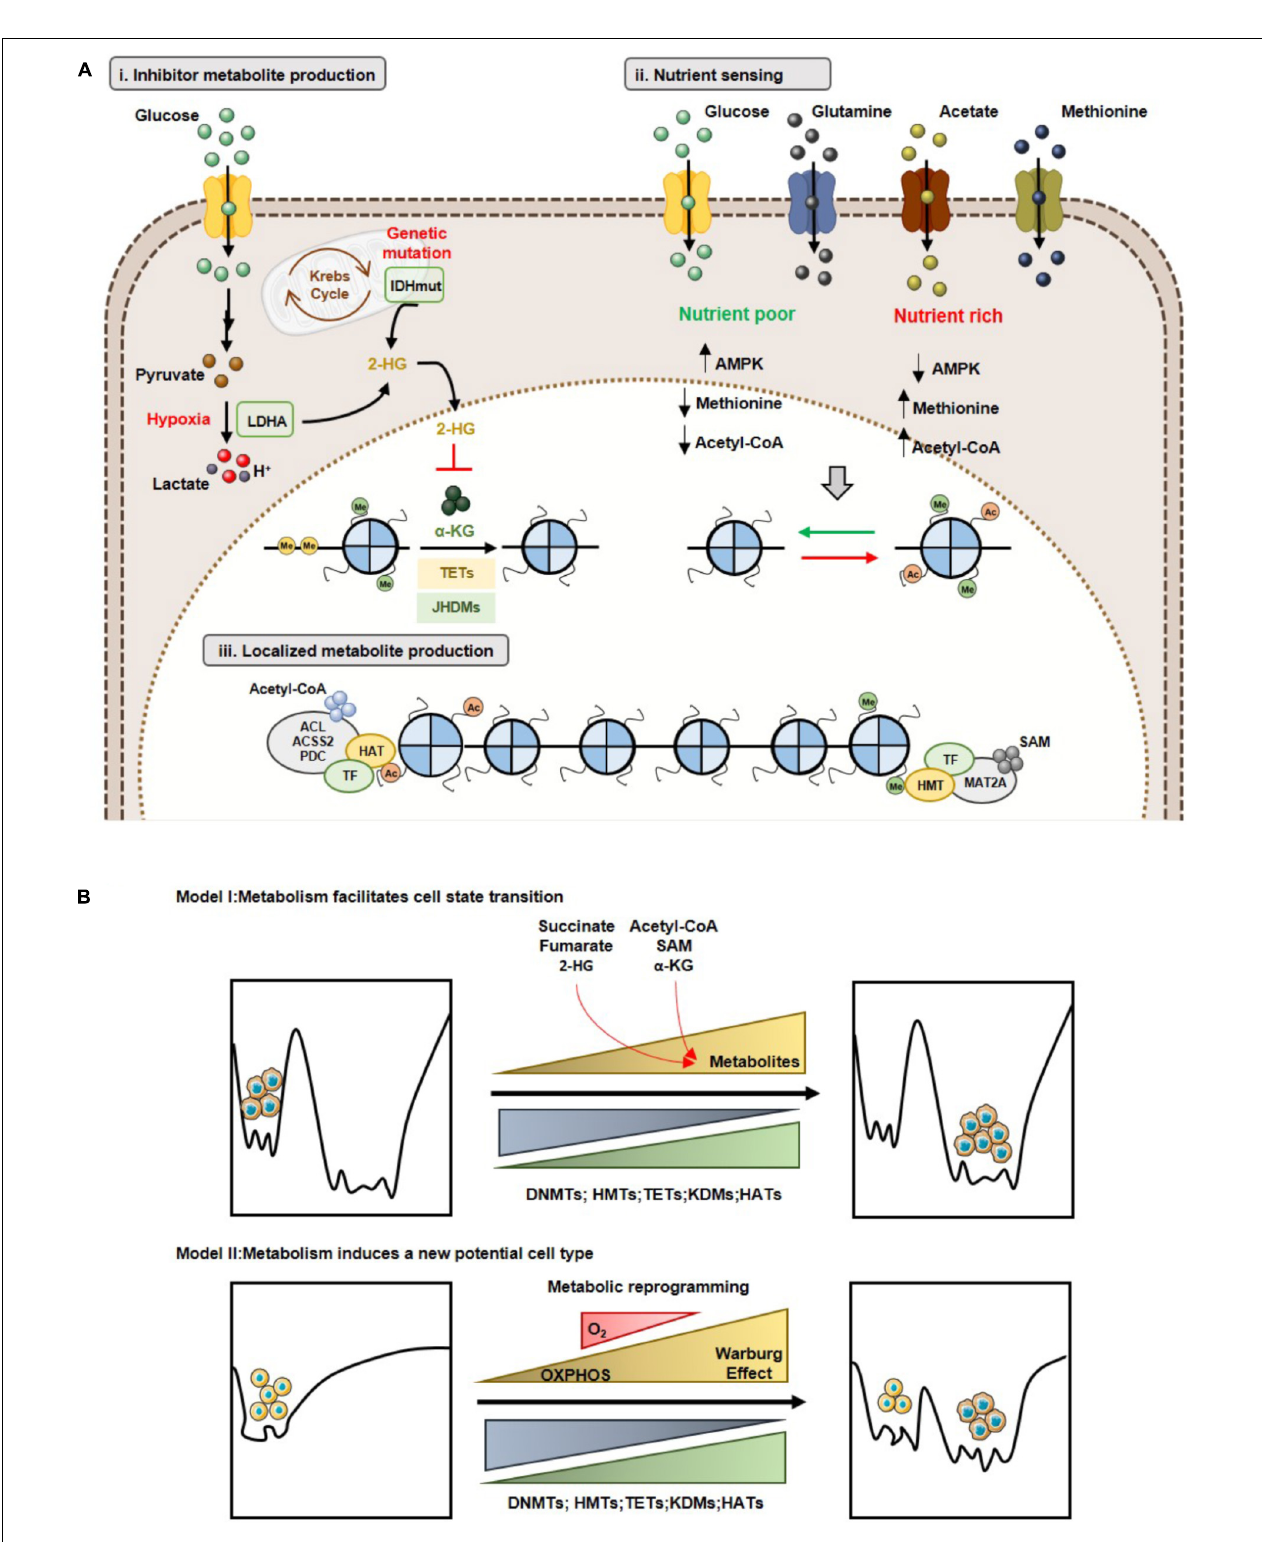
FIGURE 5 | Metabolism and epigenetic landscape interplay. (A) Models of cooperation between metabolism and epigenome: (i) Inhibitor metabolite production and chromatin regulation; (ii) Nutrient sensing and chromatin regulation; (iii) Localized metabolite production and chromatin regulation. (B) Metabolic reprogramming and Waddington’s epigenomic landscape. Model I: Changes in metabolite levels may lead to reorganization of specific chromatin marks without affecting the shape of epigenomic landscape (Top). Model II: Metabolic reprogramming leads to a new cell state with a different epigenomic landscape (Bottom).